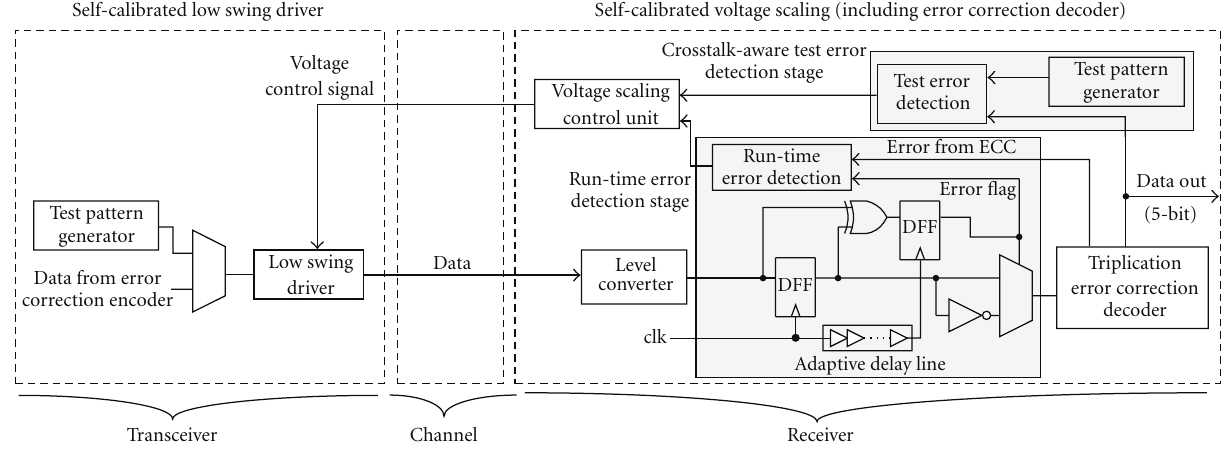
Figure 10: The block diagrams of self-calibrated voltage scaling technique with crosstalk-aware test error detection stage and run-time error detection stage.